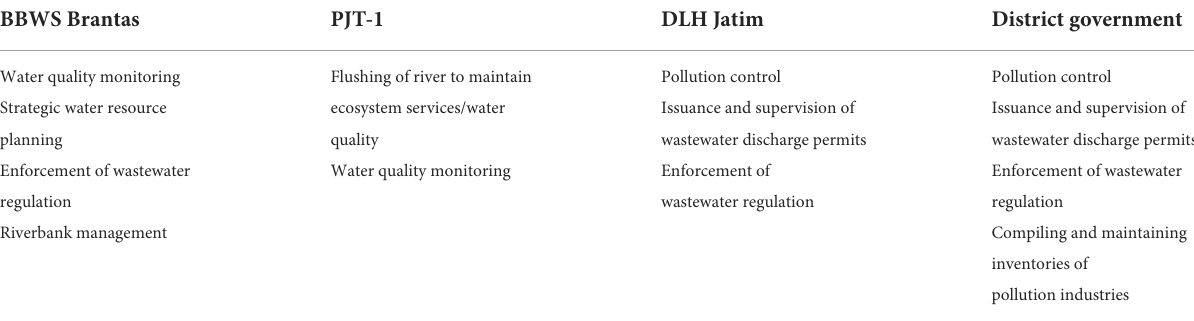
TABLE 1 Key functions of water quality management in the Brantas River basin, by agency. BBWS